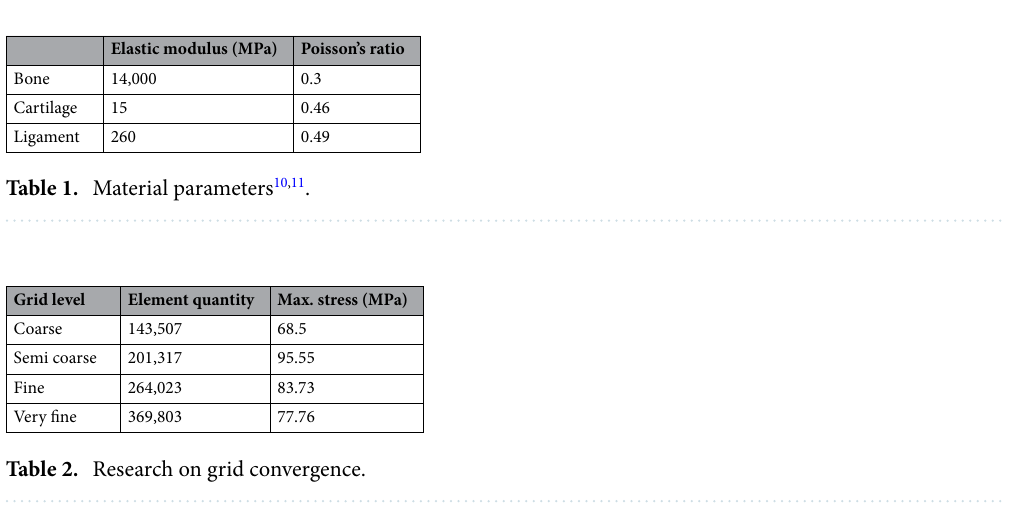
Figure 1. Process of establishing a finite element analysis model of a supination-external rotation ankle injury. ( A , B ) Surface Fitting. ( C ) the Finite element calculation grid model. ( D ) Calculation boundary.